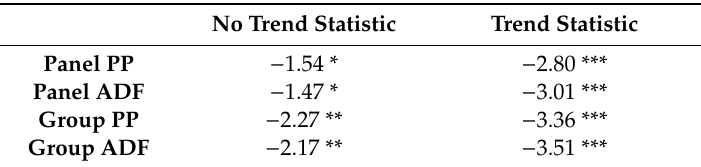
Table 5. Pedroni cointegration test results.